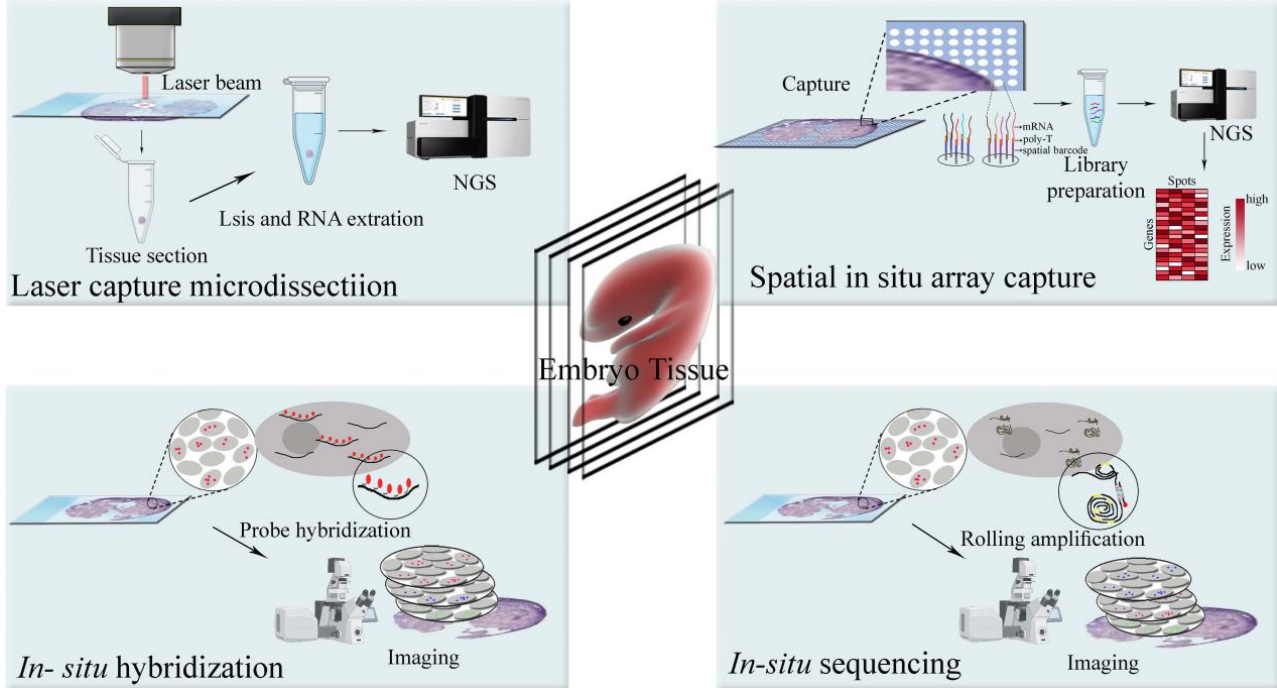
Figure 1. Schematic diagram of common ST techniques. There are two main categories of ST techniques: imaging and sequencing-based. Sequencing-based ST techniques are further classified into LCM-based or 10X Visium spatial sequencing methods. LCM-based spatial sequencing employs LCM dissection to capture the microsection of interest to be further in vitro sequenced. The 10X Visium method utilizes a spatially barcoded sequencing platform. The tissue sample is placed onto the platform without dissection and then in situ sequenced. Imaging-based ST techniques include fluorescent in situ hybridization- and in situ barcoded amplification-based methods. Fluorescent in situ hybridization-based ST techniques rely on direct imaging of individual RNA molecules in single cells using multiple fluorophore-labeled probes. In situ barcoded amplification-based methods are also based on in situ hybridization, but they use a distinct probe called padlock to amplify the hybridization signal through rolling amplification, thereby enhancing transcript capture depth.